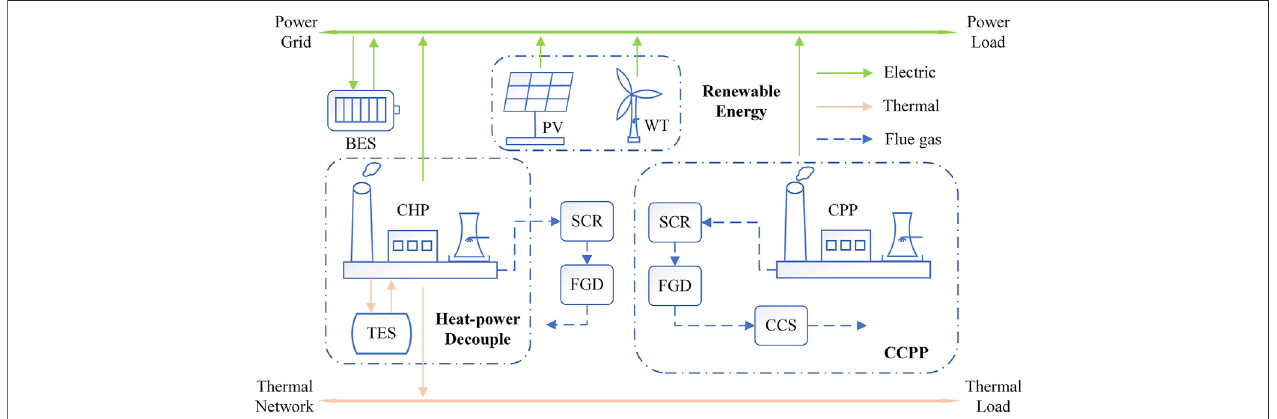
FIGURE 5 | Diagram of the IES including carbon and pollutant reduction